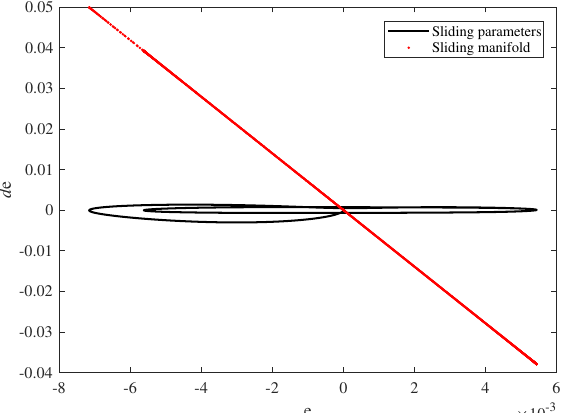
Figure 9. The ternary phase diagram of e -